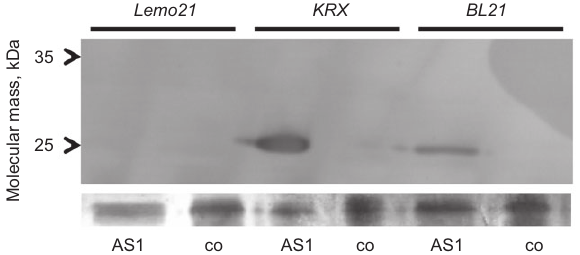
Figure 2 Western blots of N-terminally strep-tagged active site 1 in different E. coli